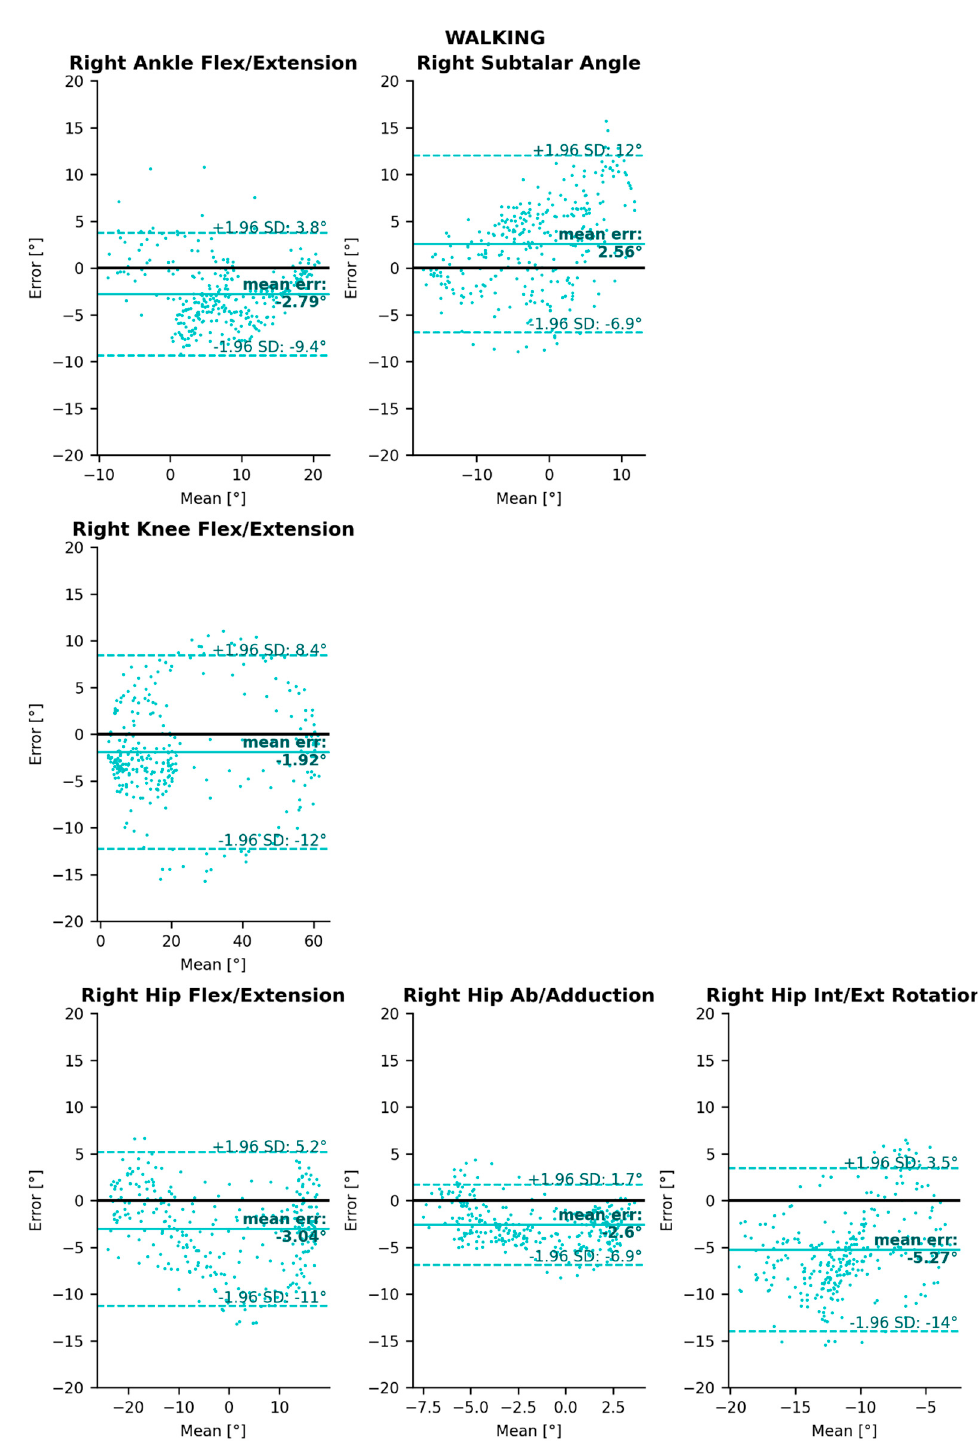
Figure 5. Bland–Altman analysis of lower-body joint angle errors for the walking task. Mean bias is represented as a horizontal solid, bold line, and 95% limits of agreement are represented as dotted lines. See Appendix A for running and cycling results, and for sacro-lumbar and upper-body results.